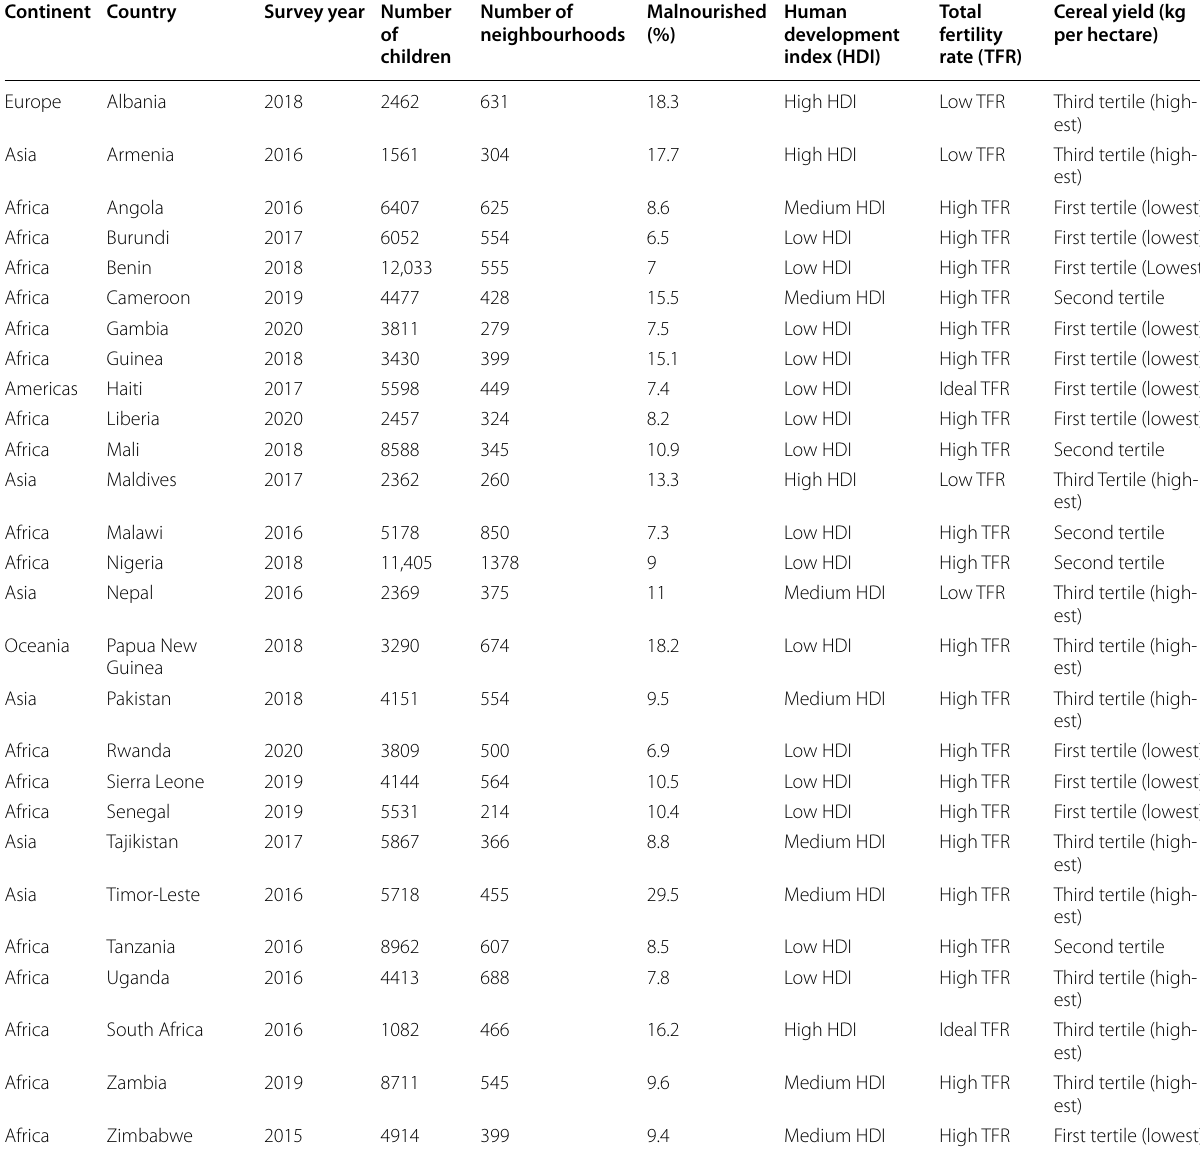
Table 1 Description of demographic and health surveys data by countries Continent